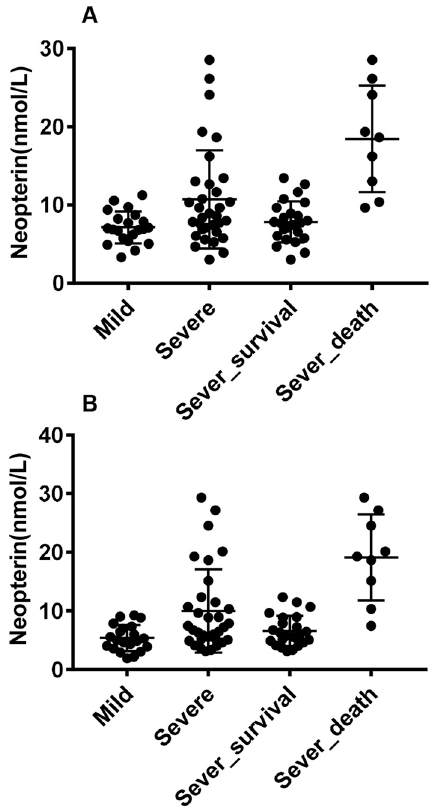
Figure 1: Scatter plot of serological neopterin level at days 8, 14 in different groups. (A) Scatter plot of serological neopterin level at day 8; (B) Scatter plot of serological neopterin level at day